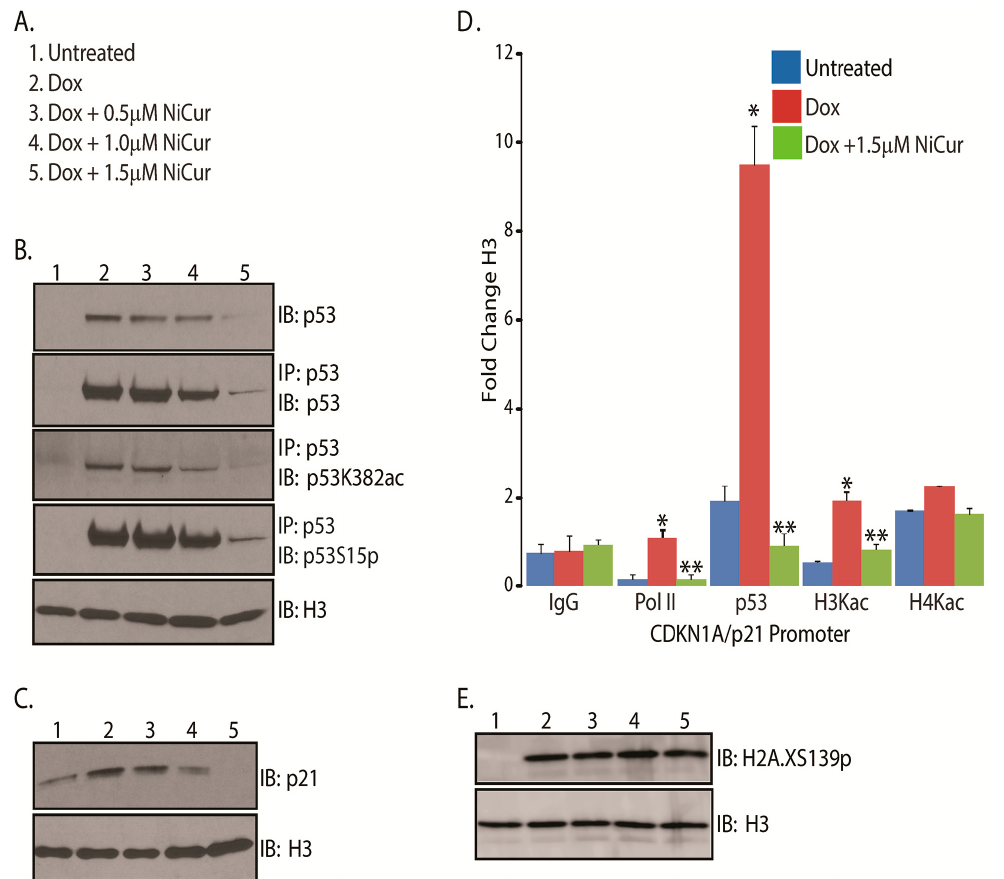
Figure 3. Dose-dependent inhibition of p53 in U2OS cells by NiCur. ( A ) Experimental conditions followed for the treatment of U2OS cells with Dox alone and together NiCur. The serial number denotes the experimental conditions with respect to the increasing concentrations of NiCur in the immunoblot panels; ( B ) IP and IB analysis showing expression levels of total p53, acetylated and phosphorylated p53 at lysine 382 and serine 15 in U2OS cells treated with conditions as described in ( A ). ( C ) IB analysis on the lysates of U2OS cells treated as per experimental conditions as described in ( A ) using antibodies to p21, and histone H3 (controls); ( D ) The fold change between the treatments of U2OS cells with Dox alone and together with NiCur that affected the enrichment of RNA Polymerase II, p53, H3Kac, and H4Kac on CDKN1A/p21 promoter were expressed as the mean ± SEM ( n = 3 ), with significance at p < 0.05 or p < 0.01 indicated by * and ** respectively; ( E ) IB analysis using H2A.XS139p antibodies from the nuclear extracts of U2OS cells treated with conditions as described in ( A